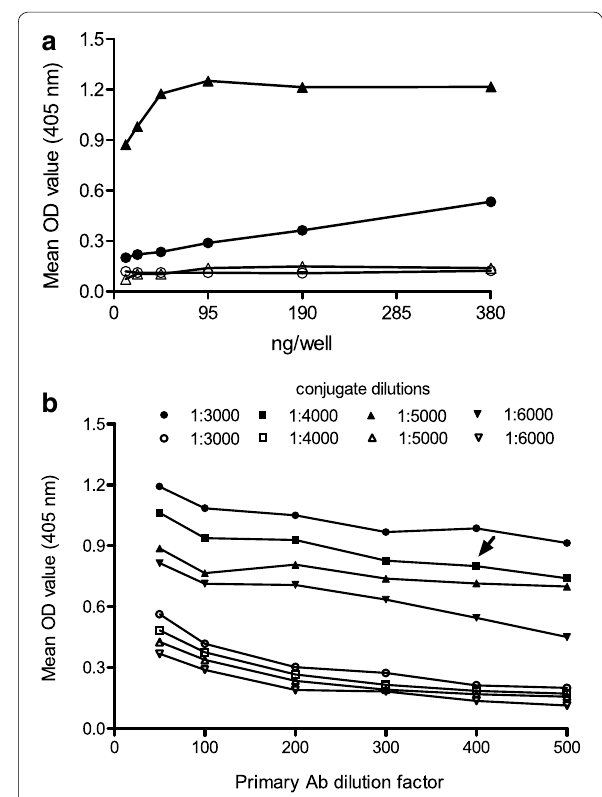
Fig. 3 Titration of the ELISA-SVP reagents. a Antigen titration. Serial two-fold dilutions of boiled (circles) and non-boiled SVP (triangles) were titrated using 1:100 anti-IBDV and negative serum (open symbols). Anti-chicken antibody conjugated to peroxidase was used in dilution 1:3000. SVP were boiled for 3 min and then assayed. b Checkerboard titration between primary and conjugate antibodies. Polyclonal sera anti-IBDV diluted 1:50 to 1:500 and anti-chicken HRP diluted 1:3000 to 1:6000 were assayed using SVP (curves with closed symbols) or control sample (curves with open symbols). The arrow indicates the working dilutions of